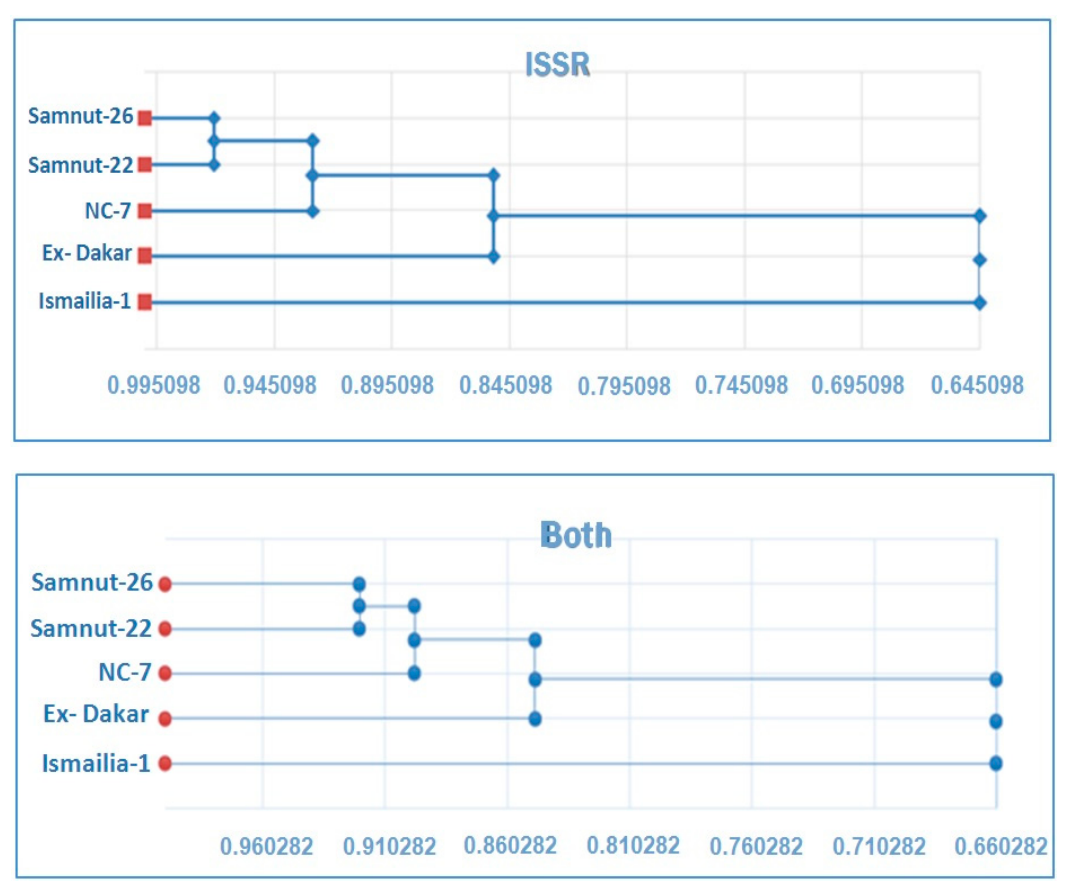
Figure 1. Phenogram generated by unweighed pair group method arithmetic average (UPGMA) cluster analysis, based on Nei and Li Coefficient, showing the cluster of peanut cultivars.